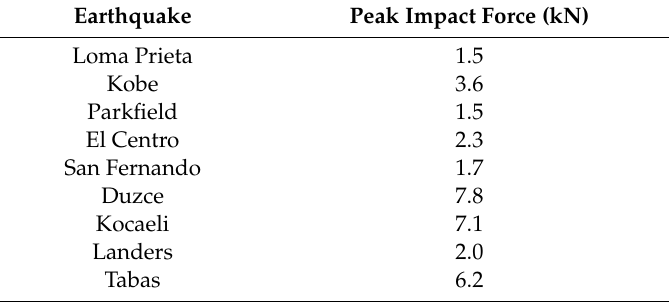
Figure 7. Peak impact force with relation to structural damping ratio under di ff erent earthquakes. Table 3. Peak impact forces for the typical value of the structural damping ratio of